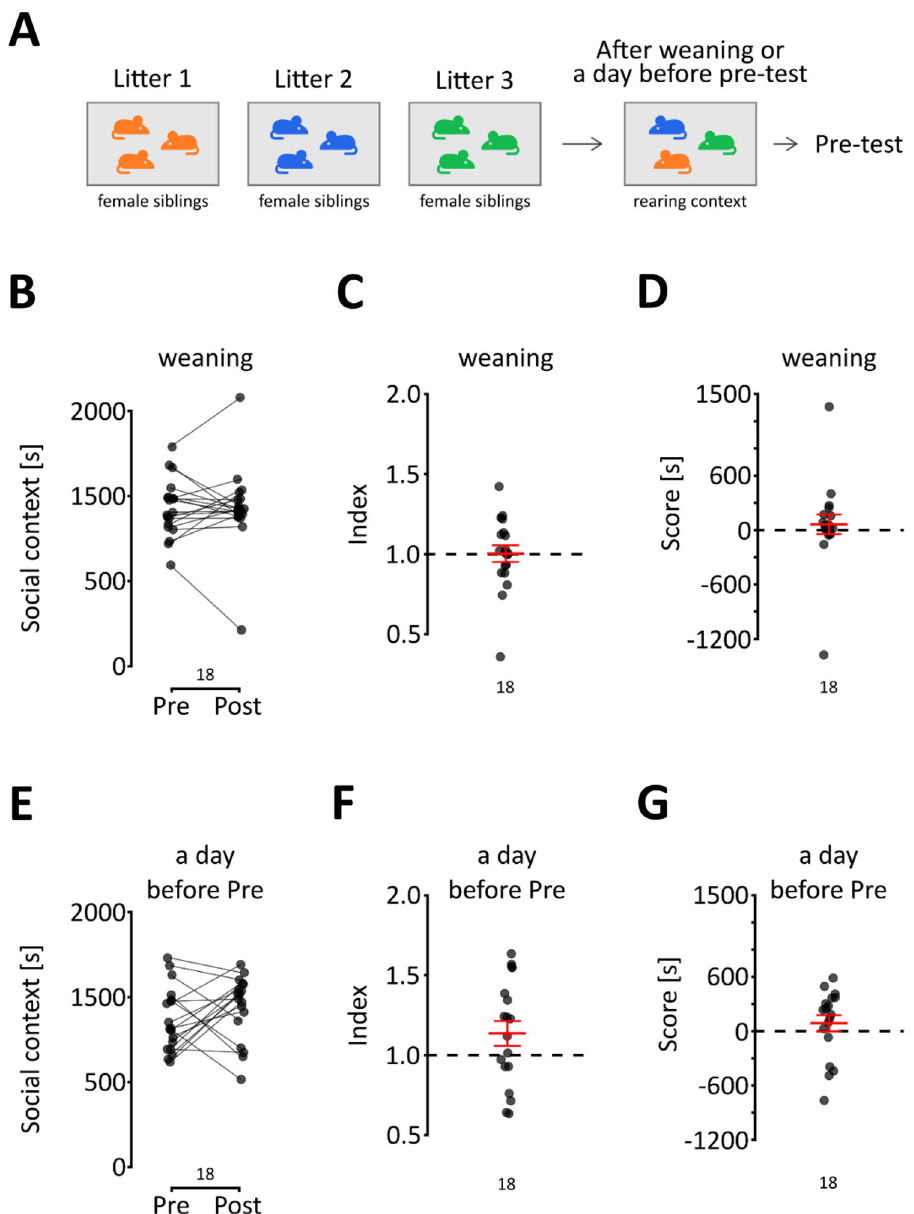
Figure 4. The effect of familiarity on social reward. ( A–C ) The change in time spent in the first context between pre- and post-test, the index and the score, respectively, in female mice that were brought together right after weaning. The mean and s.e.m. values are shown in red. ( D–F ) These graphs are the equivalents for female mice that were brought together one day before the pre-test. The mean and s.e.m. values are shown in